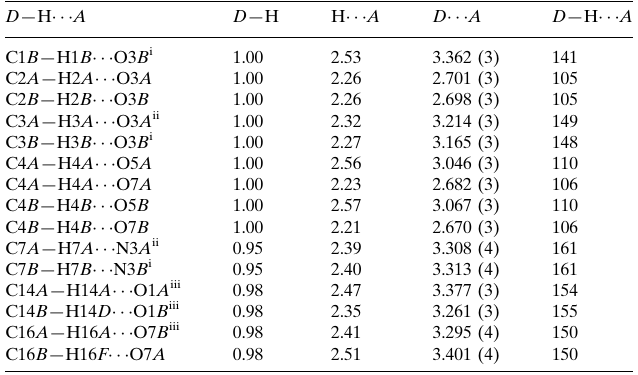
Hydrogen-bond geometry (A˚ , (cid:3) ). D —H (cid:2)(cid:2)(cid:2)